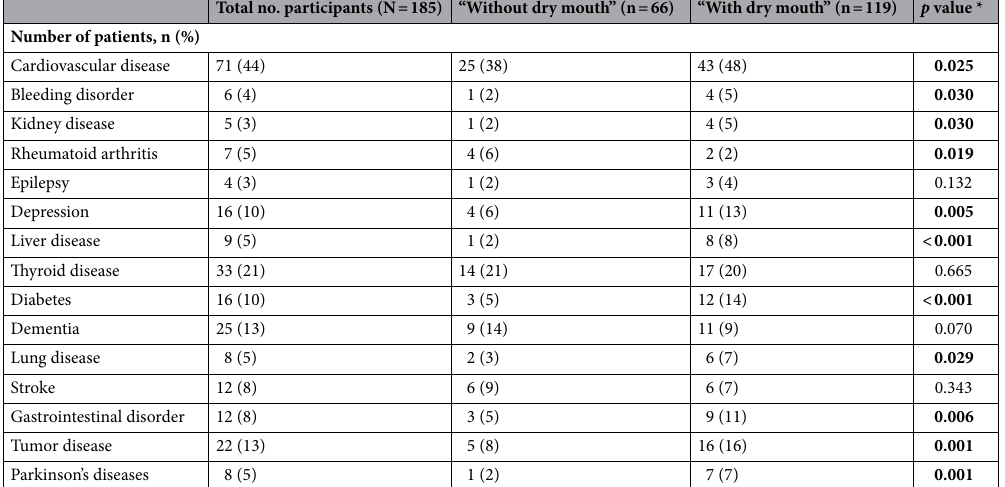
Total no. participants (N = 185) “Without dry mouth” (n = 66) “With dry mouth” (n = 119) p value